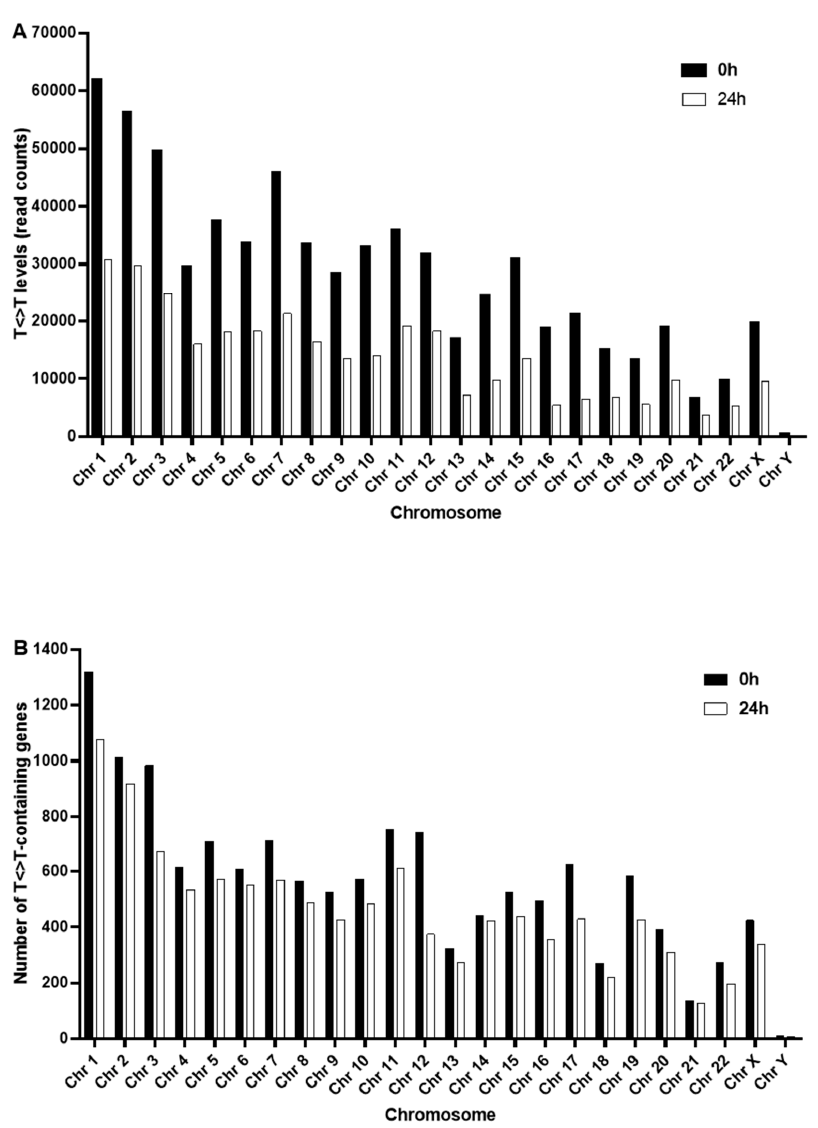
Figure 5. Distribution of T <> T levels (read counts) between chromosomes, in HaCaT cells irradiated with SSR, mapped to the human genome assembly GRCh38. ( A ) indicates the total level of T <> T per chromosome immediately post-SSR exposure (filled bars), and 24 h later (open bars). ( B ) indicates the number of damaged genes (i.e., containing one or more damaged moiety) per chromosome, immediately post-SSR exposure (filled bars), and 24 h later (open